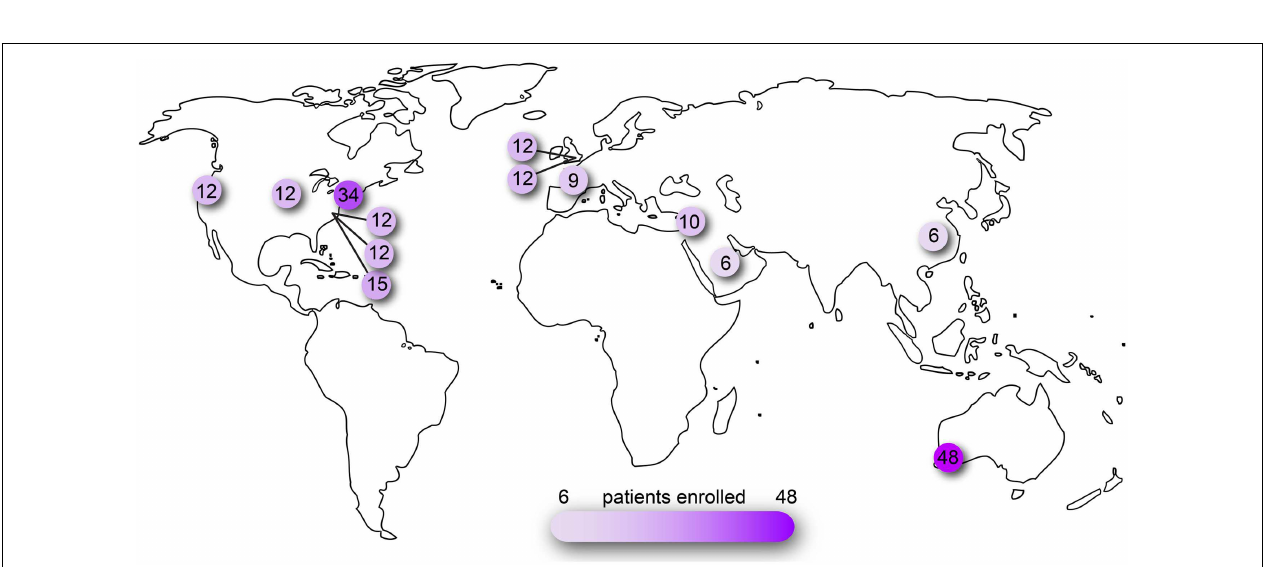
FIGURE 1 |Trends in vectors studied for gene therapy in the eye . (A) Number of results returned when the MEDLINE database was queried via PubMed for “aav eye 2001” etc. (B) Newly registered clinical trials by year